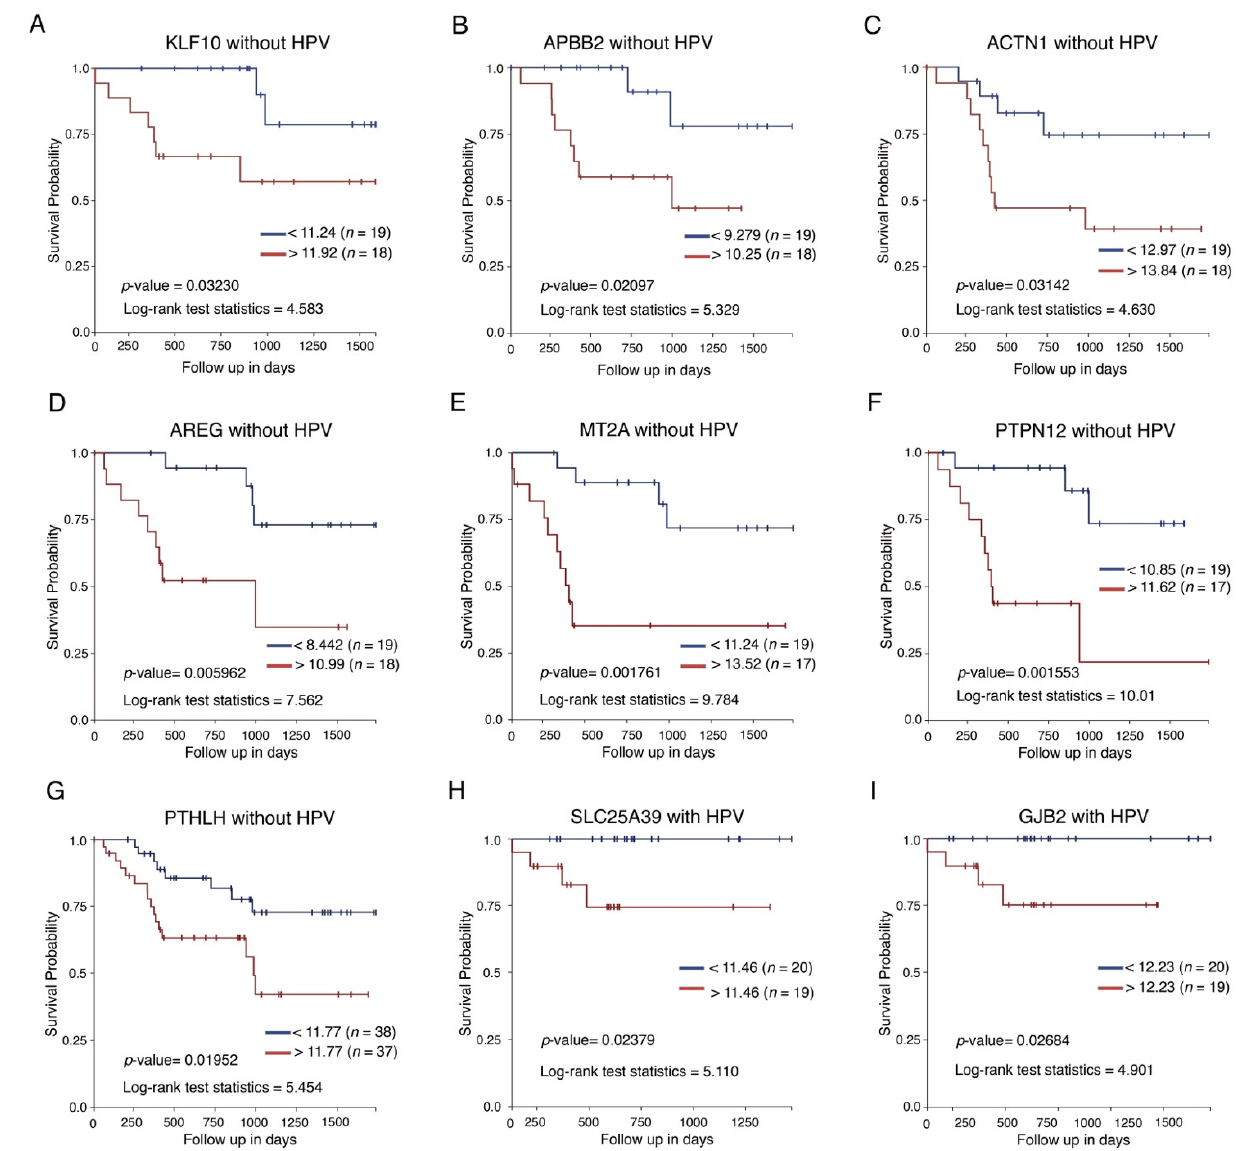
Figure 5. Differentially expressed mRNAs show clinical importance in patients with HNSCC according to HPV status. ( A – G ) Kaplan–Meier curves comparing global survival with respect to expression of DE genes in HPV negative samples (KLF10, APBB2, ACTN1, AREG, MT2A, PRPN12, and PTHLH. ( H , I ) Kaplan–Meier curves comparing global survival in relation to DE genes in HPV+ samples, but not samples without viral infection (SLC25A39 and GJB2). p values are shown in each graph.